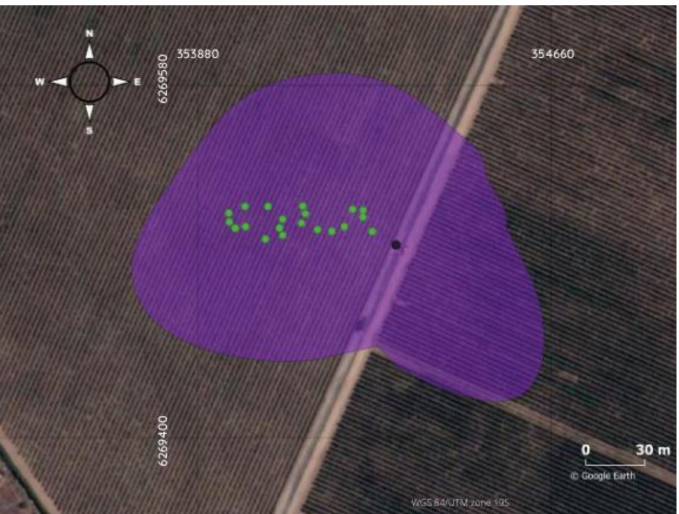
Figure 2. Vineyard study area and climatological footprint. Black dot is eddy covariance system (EC) localization. Purple line contour is footprint 90% flux source area. Green dots are places where phenology and radiation intercepted by canopy were